Question: What does this figure show? Answer in one sentence.
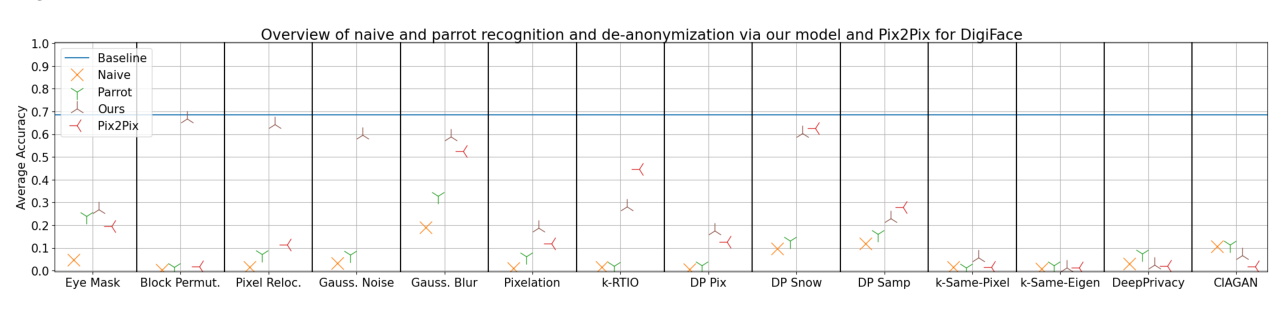
Answer: Average recognition accuracy for every anonymization method for baseline, naive, parrot, de-anonymized via our model, and de-anonymized via Pix2Pix; on 300 identities on DigiFace-1M.